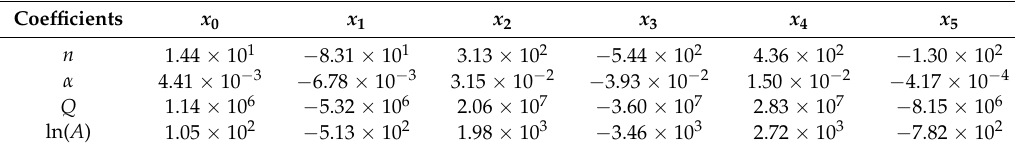
Figure 3. Model parameter analysis. ( a ) polynomial fitting of A , α , n , and Q ; ( b ) hot deformation activation energy analysis. Table 2. Coefficients of the fifth‐order polynomial fitting.